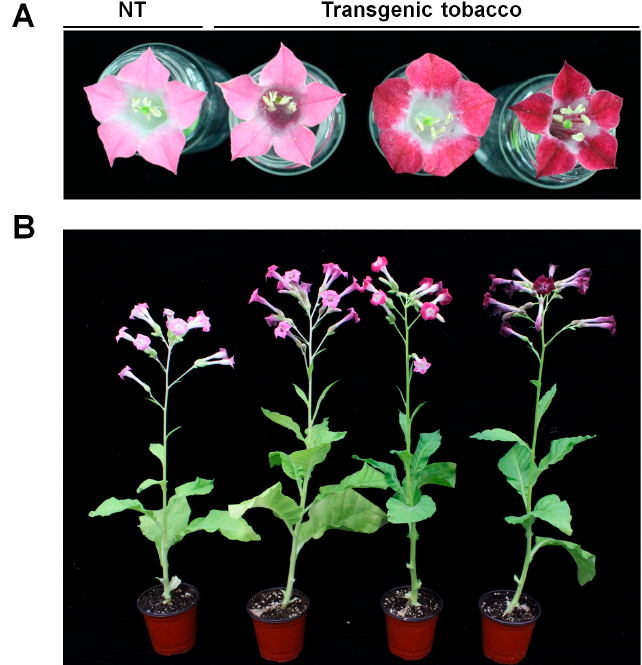
Figure 1. Pigmentation phenotypes of PANSBP transgenic tobacco plants. Representative pigmentation phenotypes of NT and PANSBP transgenic tobacco plants are shown. NT tobacco flowers were pink due to anthocyanin accumulation. The PANSBP transgenic tobacco plants displayed a range of flower colors from dark pink to dark red due to enhanced anthocyanin accumulation in petals ( A ); Leaves lack visible anthocyanin pigmentation in NT and PANSBP transgenic tobacco plants ( B ).